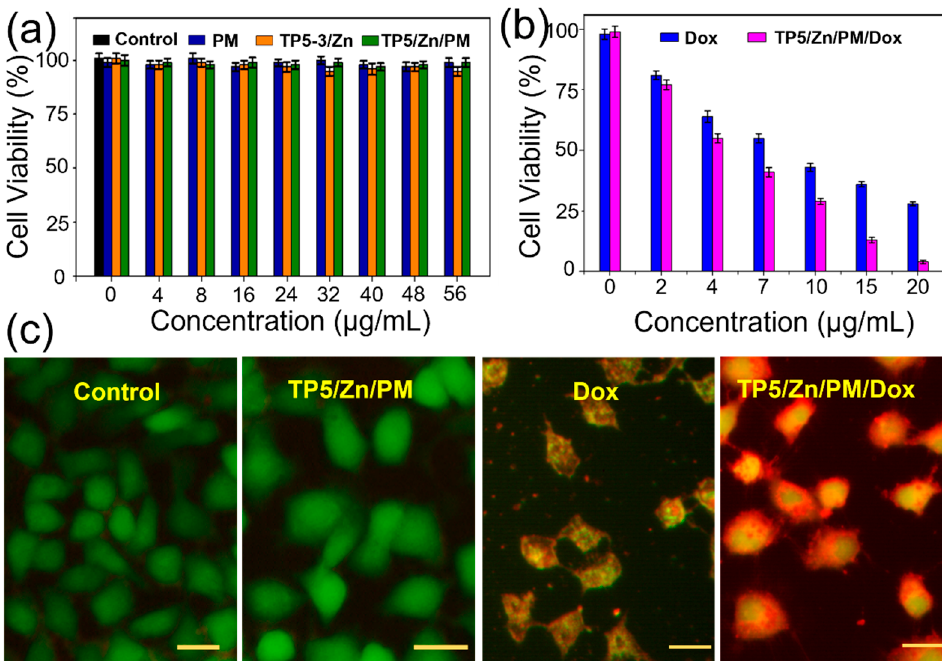
Figure 5. ( a ) The viabilities of HeLa cells cultivated with different concentration of PM , TP5/Zn and TP5/Zn/PM . ( b ) The viabilities of HeLa cells cultivated with different concentration of Dox and TP5/Zn/PM/Dox . ( c ) Fluorescence images of calcein-AM (live cells, green) and PI (dead cells, red) contained HeLa cells after different treatments. Scale bar = 20 µm.